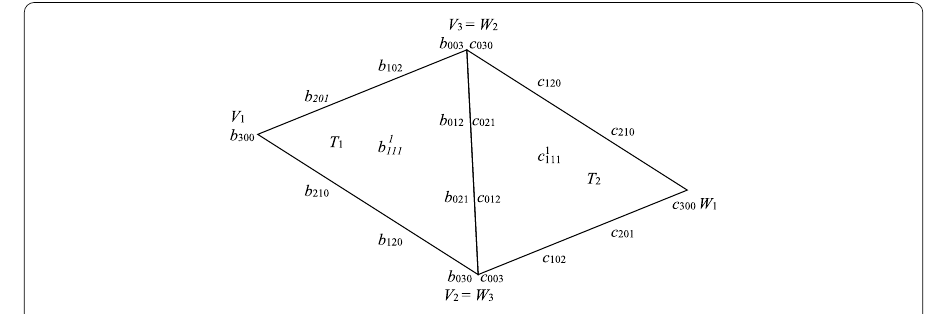
Figure 6 Two adjacent cubic triangular